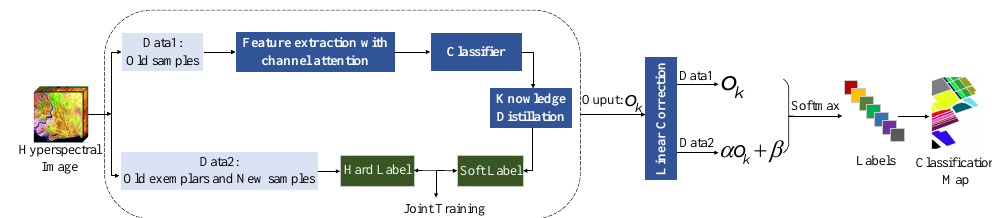
Figure 2. The framework of class-incremental learning for hyperspectral image classification, which contains four basic structures: feature extraction module, classifier module, knowledge distillation, and linear correction unit.